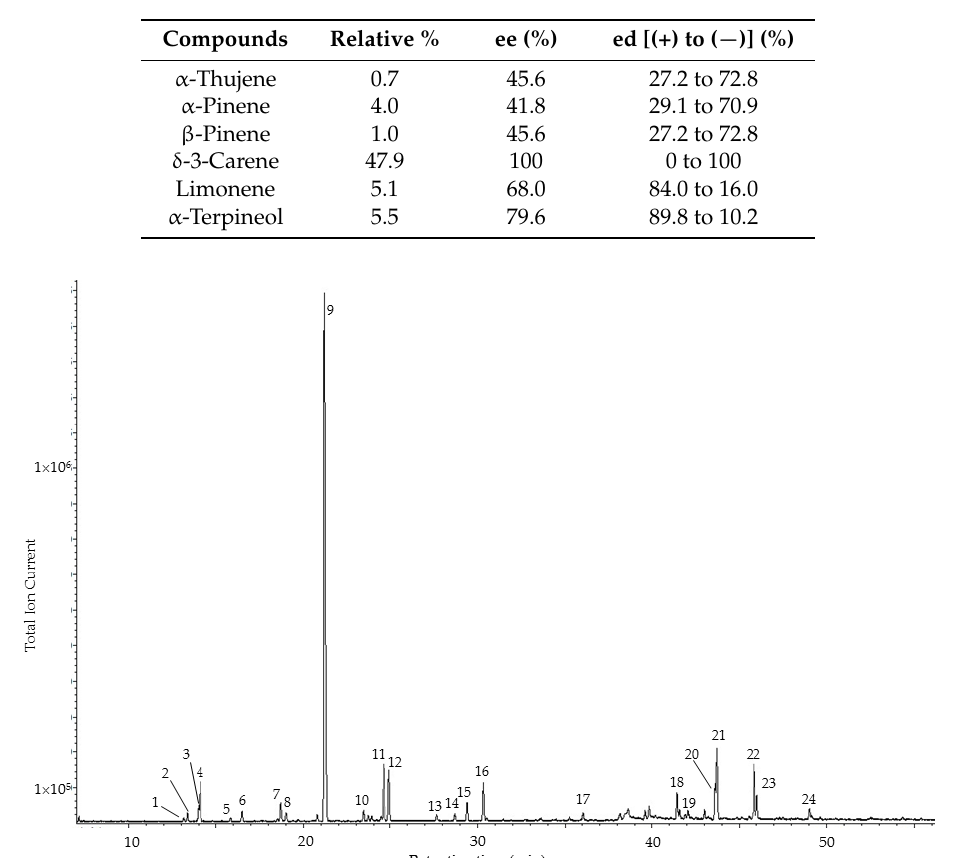
Table 3. Enantiomeric excess (ee) and distribution (ed) of monoterpenoids in the resin oil of Protium amazonicum .